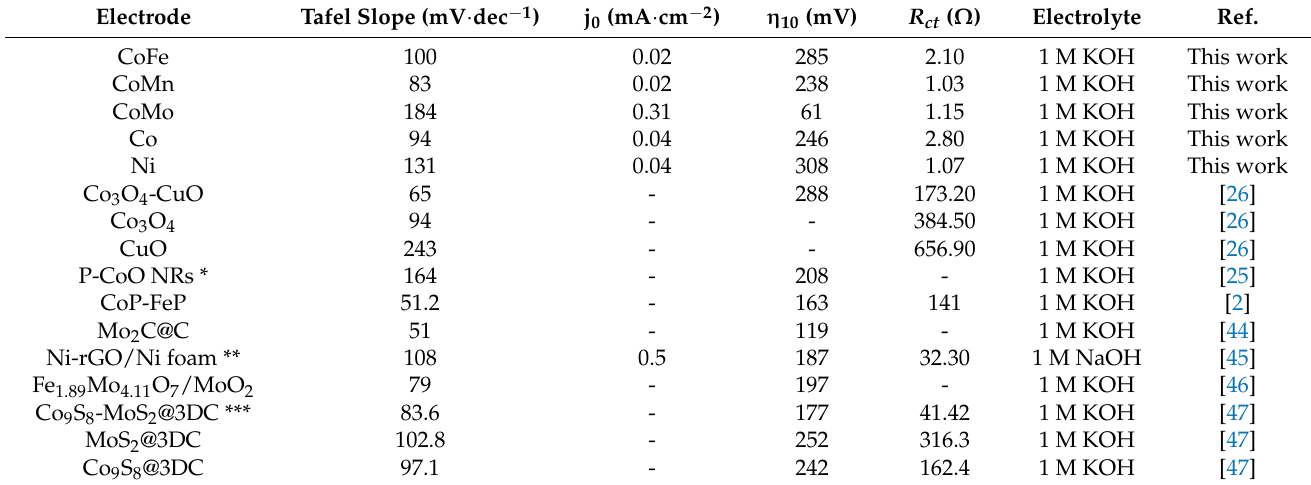
Table 7. Electrochemical performance of herein tested coatings towards HER in alkaline media and comparison with that of transition metal-based electrodes reported in the